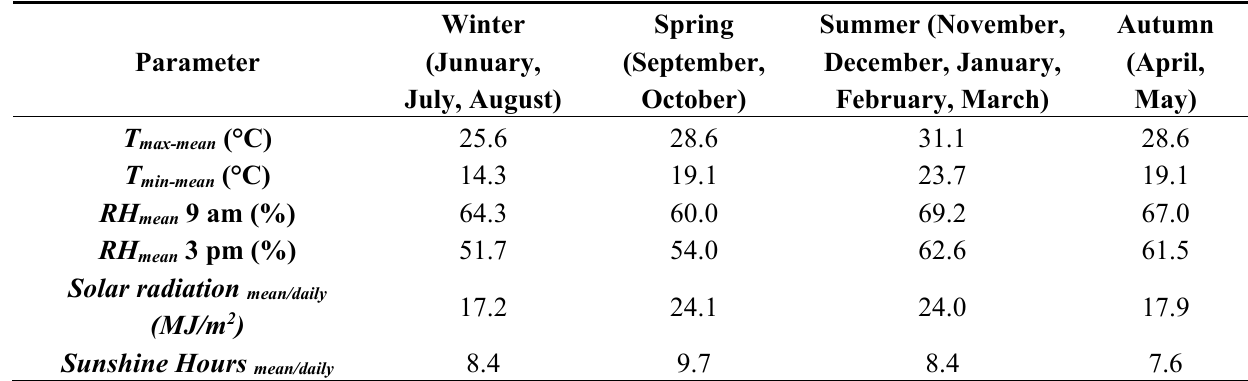
Table 2. Climate conditions and location of the case study *.